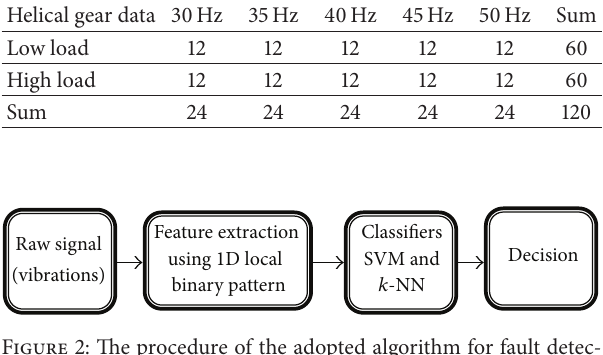
Figure 2: The procedure of the adopted algorithm for fault detec-